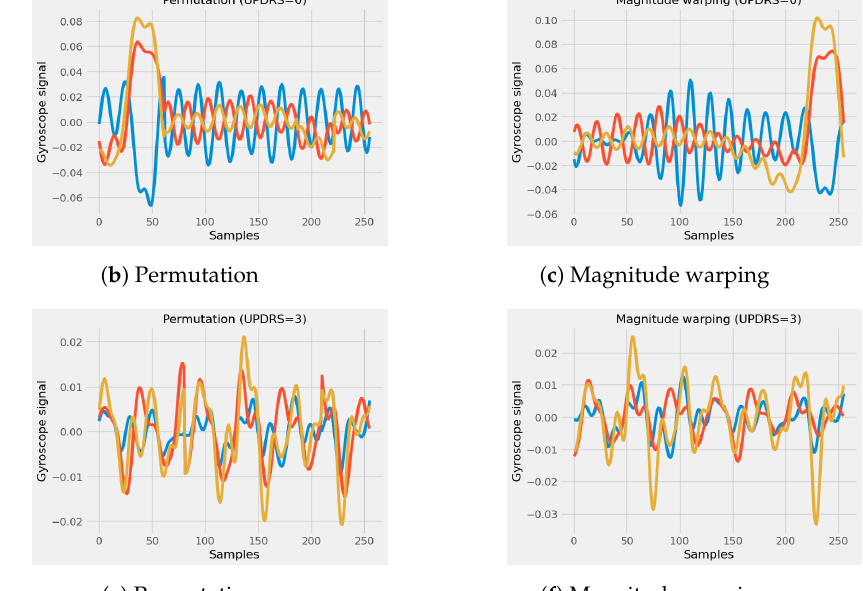
Figure 4. Data augmentation techniques applied in the gyroscope signals. ( a ) sample of the original signal corresponding to exercise 4 (finger tapping); ( b ) permutation of a sample signal of the exercise 4; ( c ) magnitude warping of a sample signal of exercise 4; ( d ) sample of the original signal corresponding to exercise 5 (hand movements); ( e ) permutation of a sample signal of the exercise 5; ( f ) magnitude warping of a sample signal of exercise